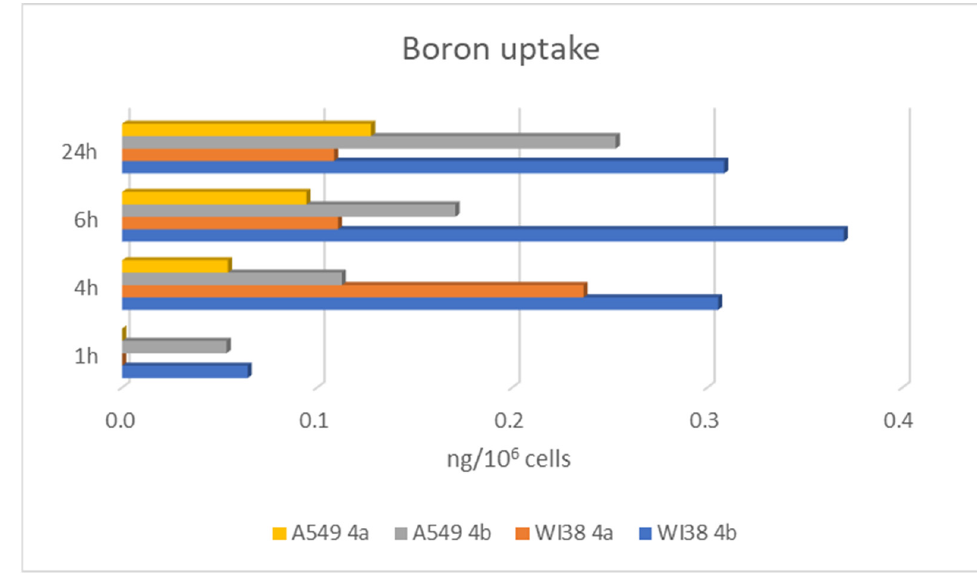
Figure 6. Cellular boron accumulation of compounds 4a and 4b in A549 and WI38